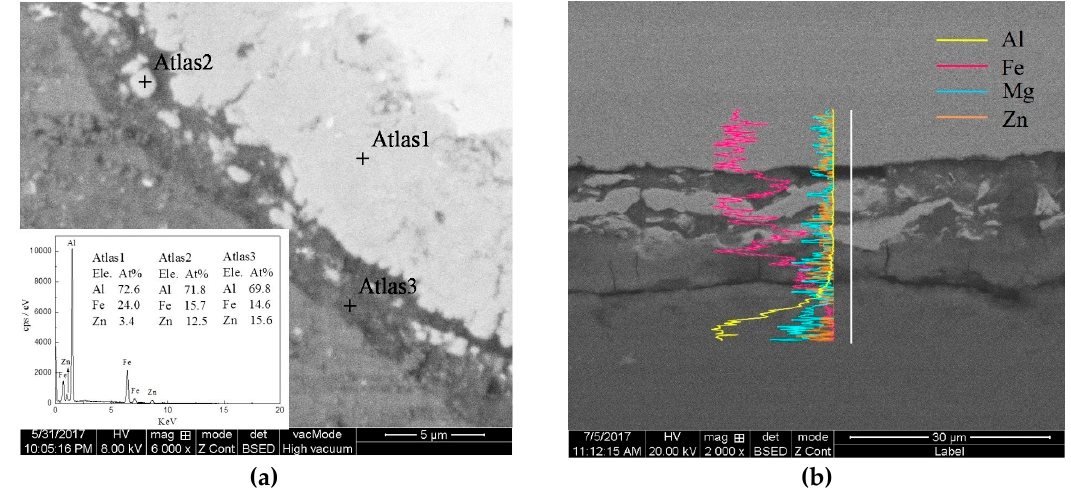
Figure 10. Micromorphology and EDS of the transition layer of the keyhole-free FSSW joint: ( a ) center area and ( b ) edge area.